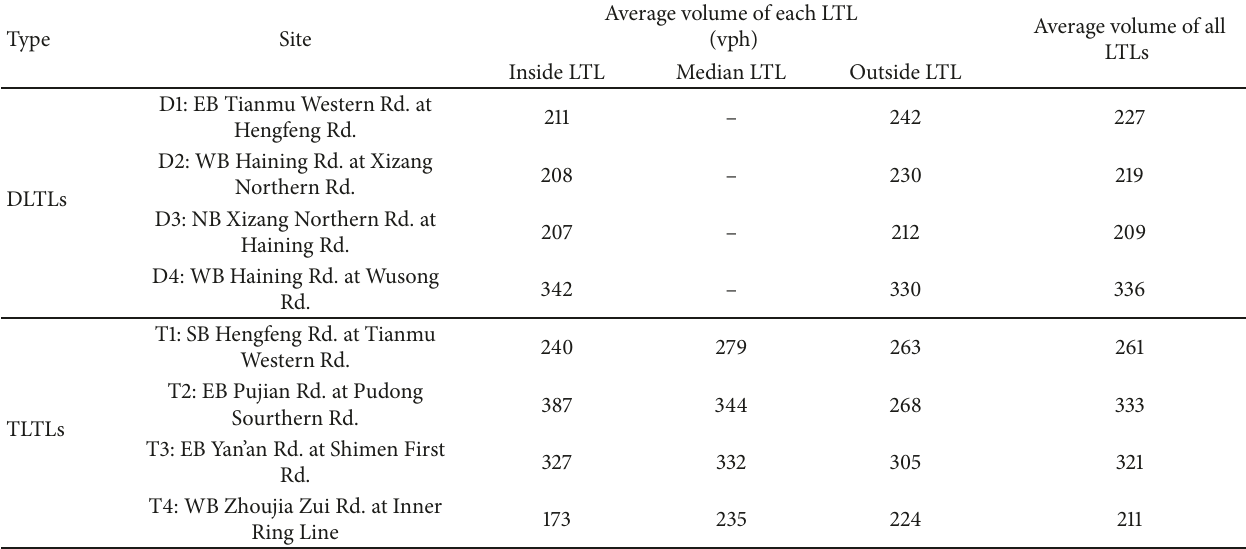
Table 4: Study site locations and the data of collected LTL volumes.